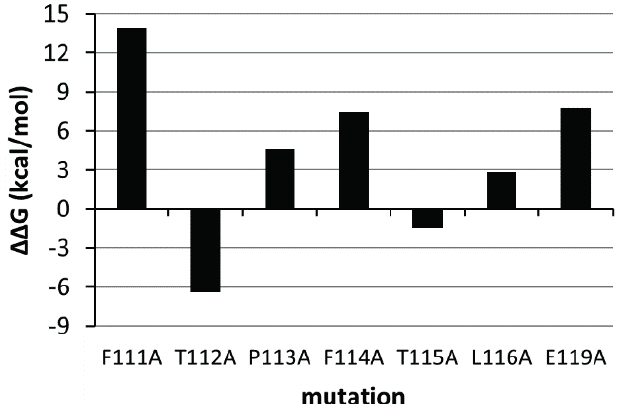
Figure 11. Estimated ΔΔ G after mutation in alanine for residues 111–116 and 119 of the G-H loop of